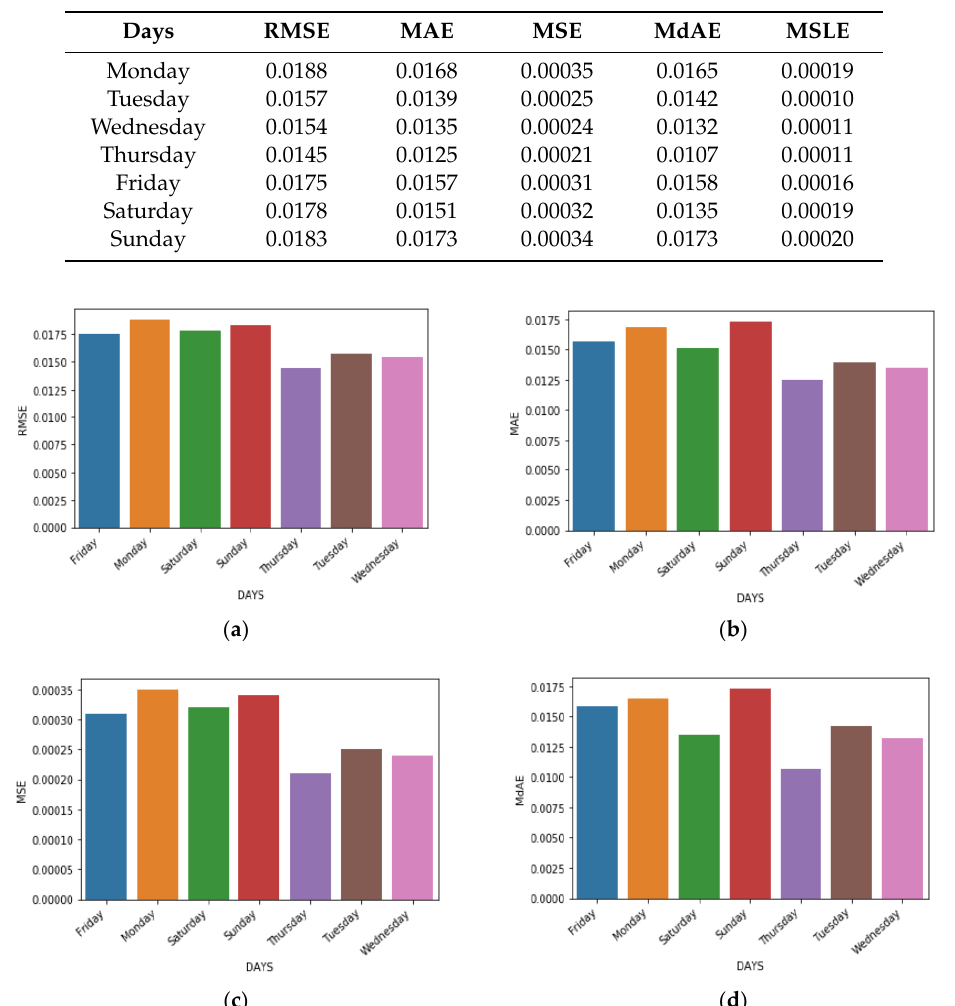
Figure 8. Parking availability prediction error rate with respect to day-wise using loss functions: ( a ) RMSE, ( b ) MAE, ( c ) MSE, ( d ) MdSE. Table 5. Hour-Wise Results of deep LSTM.